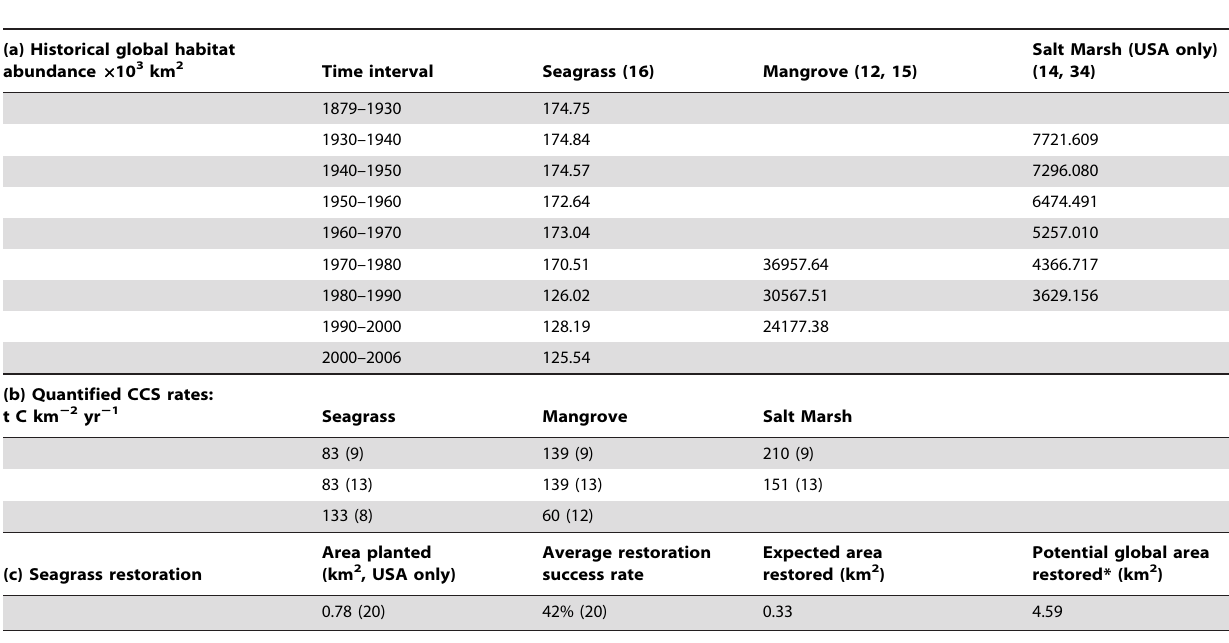
Table 1. Summary of key data sources and values used in calculations of global historical CCS rates and future changes under different habitat recovery and restoration